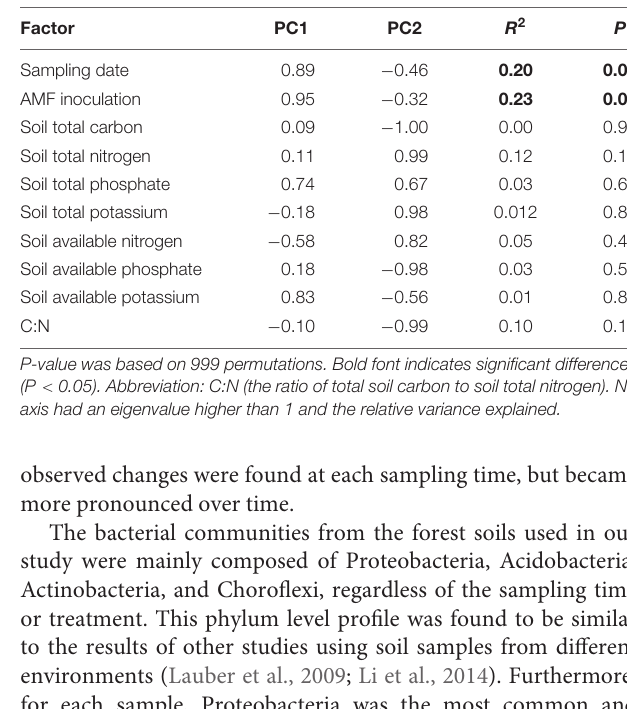
TABLE 1 | Factors corresponding with soil bacterial community